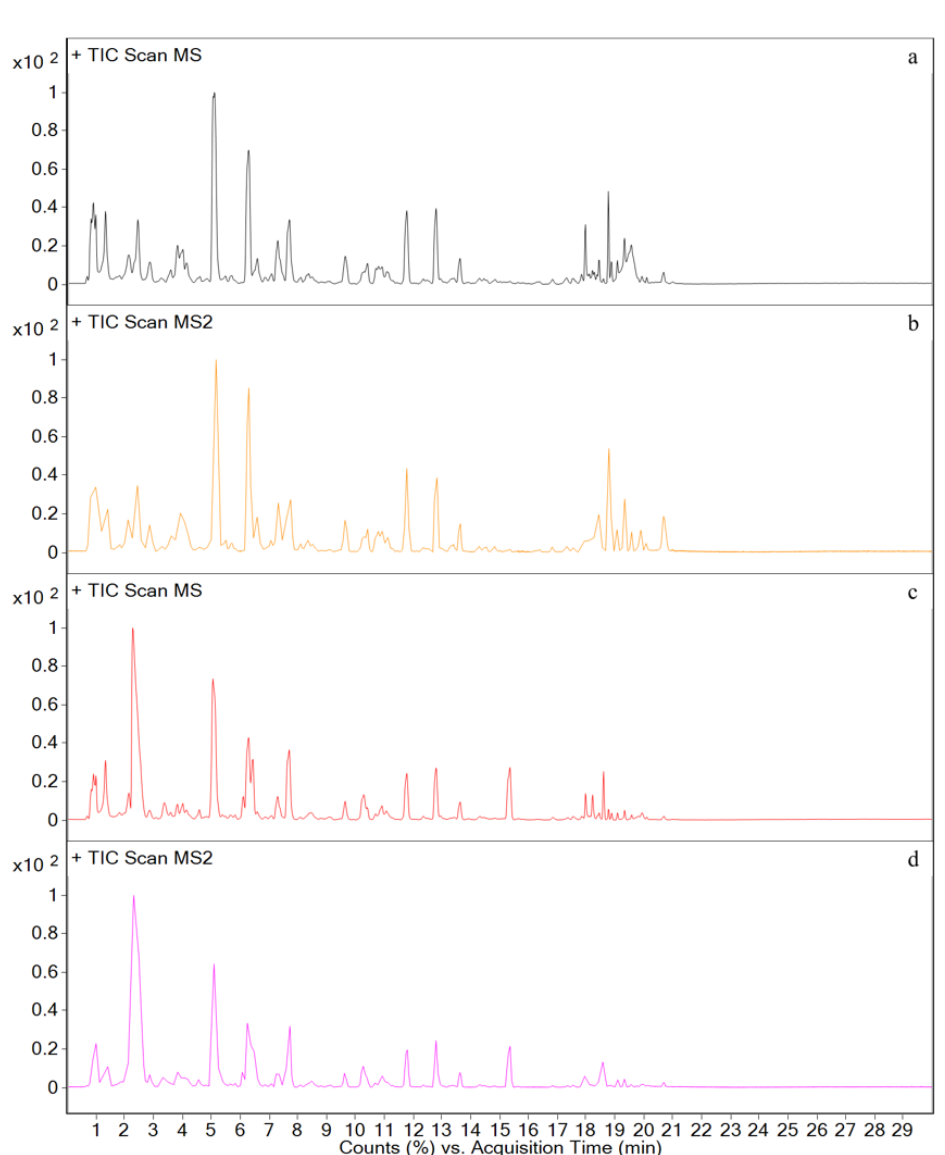
Figure A1. Total ion chromatograms of urine. ( a , b ) Blank urine; ( c , d ) Sample